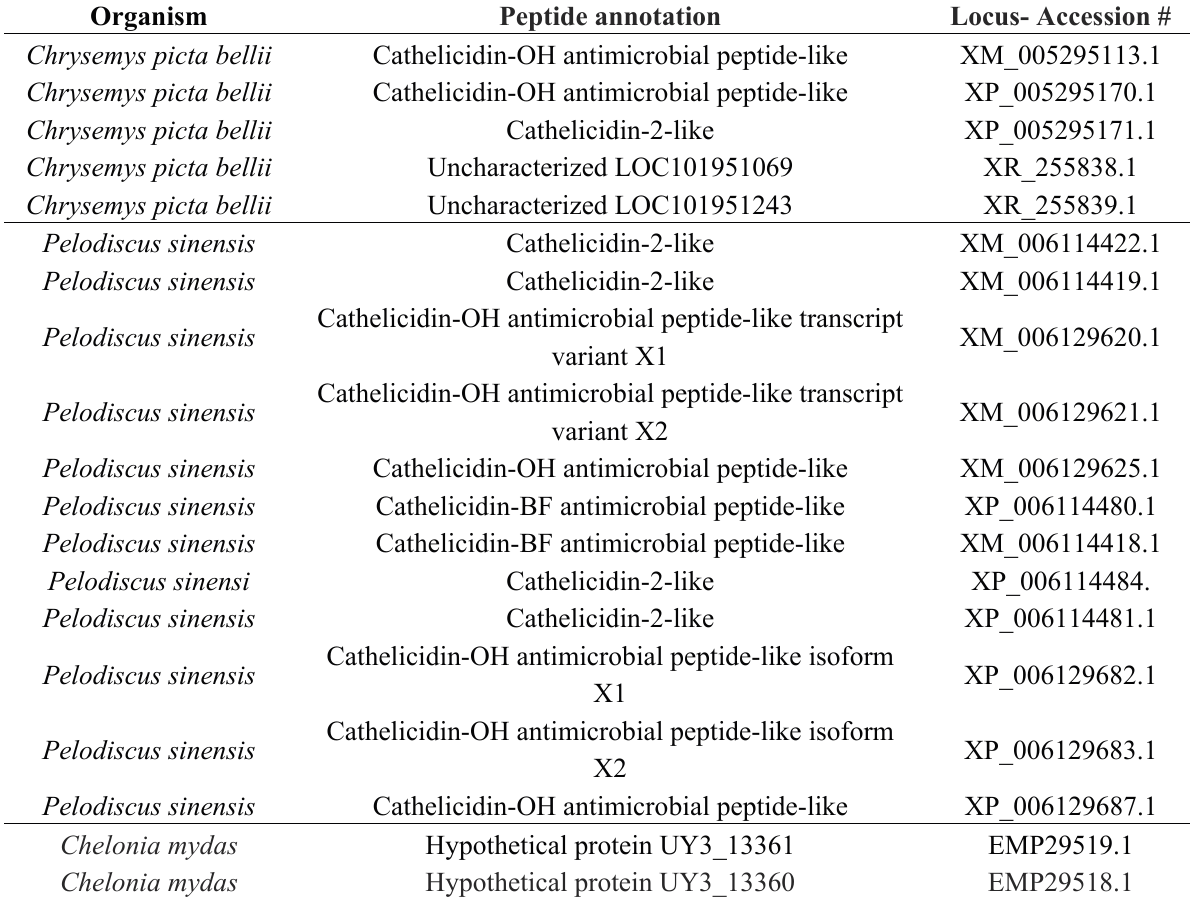
Table 5. Predicted cathelicidin pre-pro-protein genes in multiple turtle